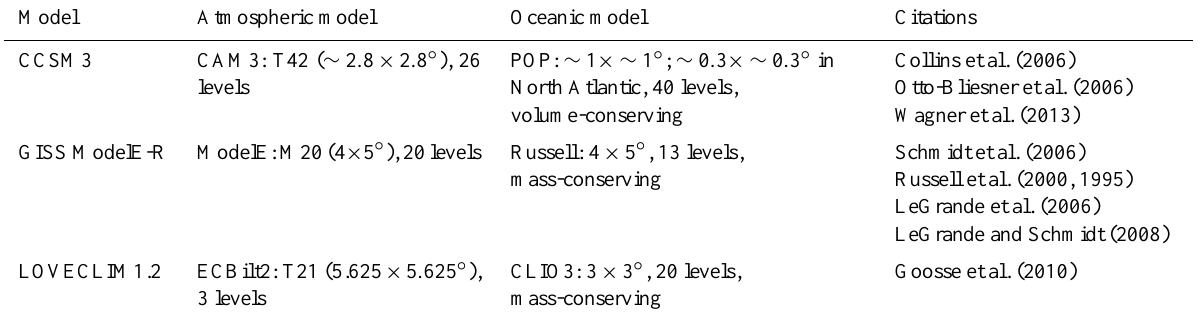
Table 1. Participating